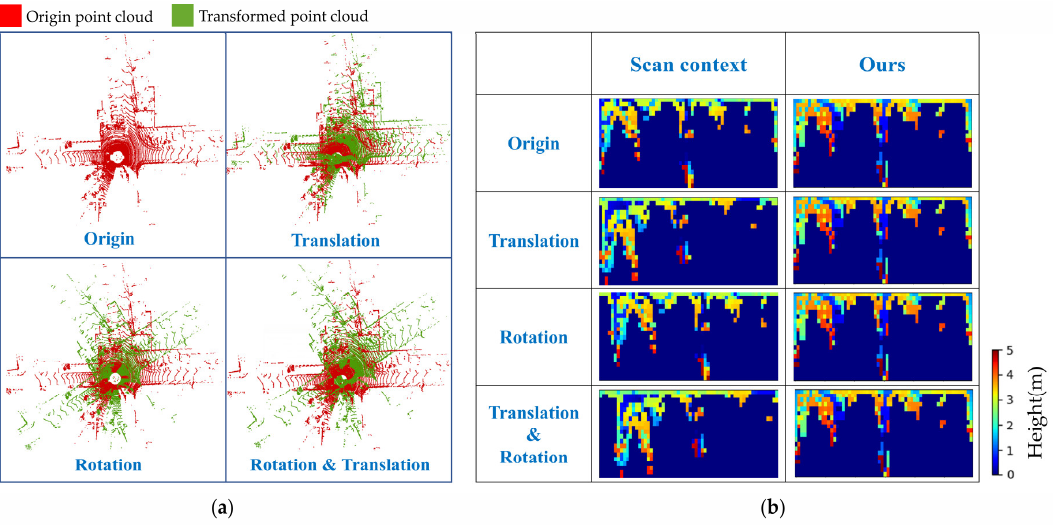
Figure 10. Comparison of the descriptors generated after the translation, rotation, and both rotation and translation of point clouds. ( a ) Point clouds with different transformations. The red color means origin point cloud and the green one means transformed point cloud. ( b ) The descriptors generated by SC and the top-view projection of 3PCD-TP; the second column with different colors means the maximum height (from 0 to 5m), and the third column with different colors means the dynamic height (from 0 to 5m).